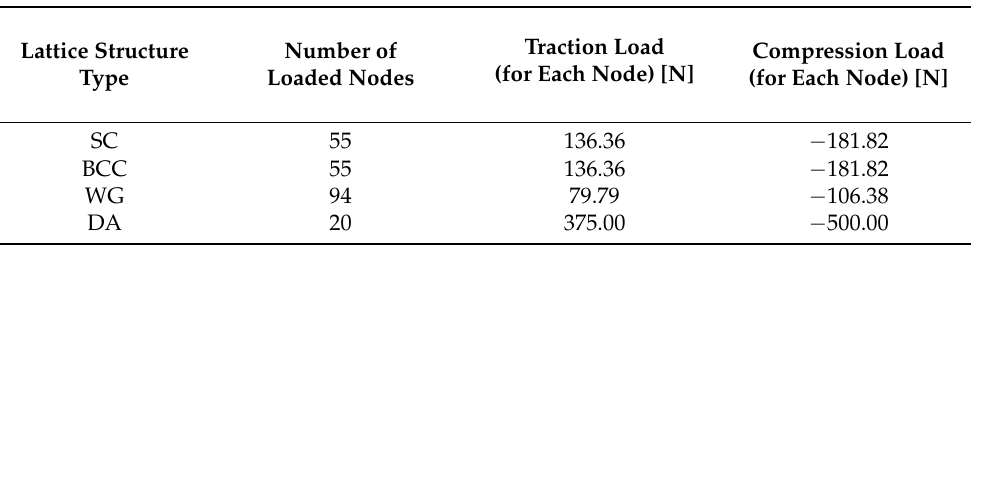
Table 1. Load information for each lattice